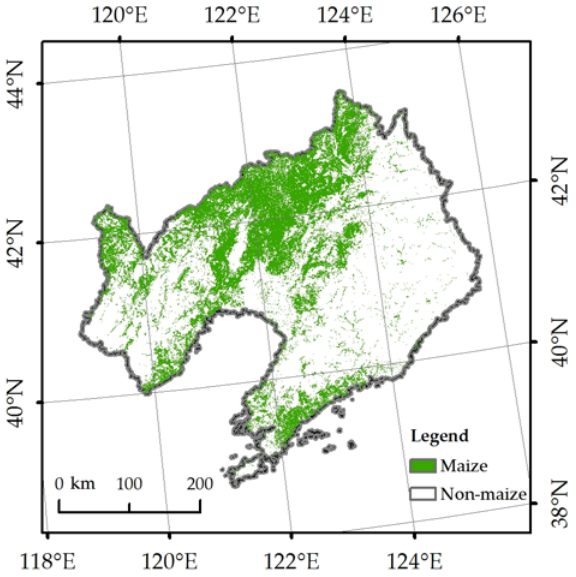
Figure 8. The spatial distribution of maize identified with the decision tree classifier from multi-metric